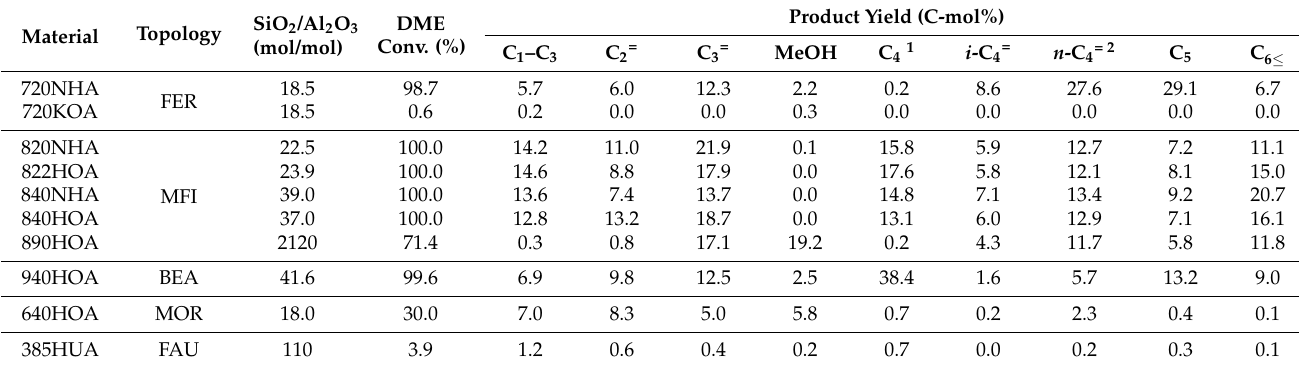
Table 1. Catalytic performance in DTO reaction using various